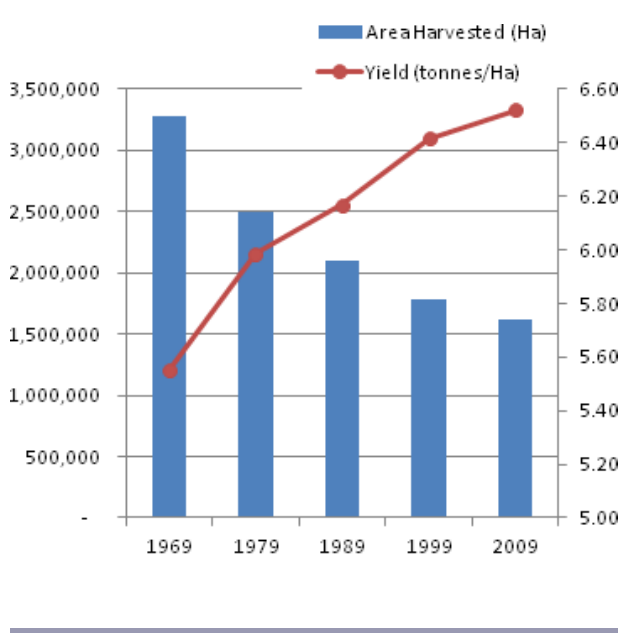
Fig. 4 . The change in rice production and harvest area in Japan.